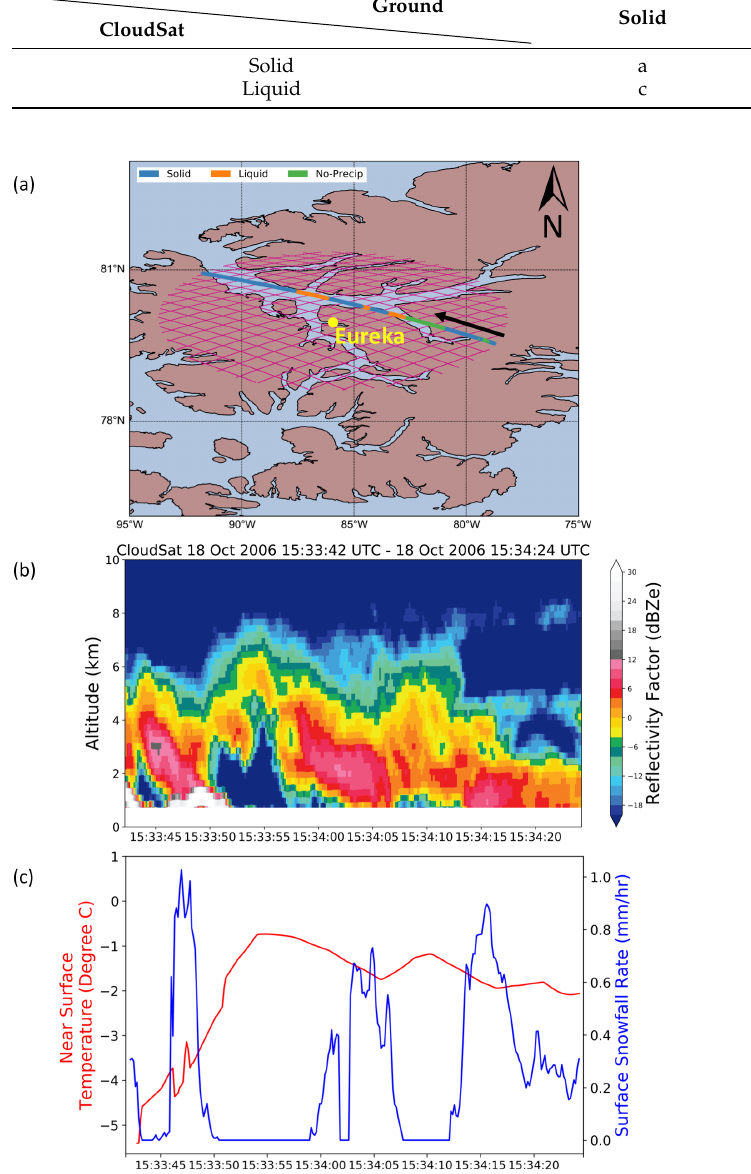
Figure 2. Figures demonstrating the details of the overpass validation methodology for a mixed precipitation event at Eureka, Nunavut recorded on 18 October 2006 at UTC 15:33. ( a ) A spatial radius of 100 km centered on Eureka weather station, and the magenta lines indicate the tracks of CloudSat overpasses included in this study. Each individual overpass comprises retrieval profiles recorded along the track every 0.16 s. The multicolored line shows one CloudSat overpass on 18 October 2006, with retrieval profiles color-coded by precipitation occurrence and type using the method described in Section 3.1. ( b ) The vertical profile of reflectivity measured by CloudSat along the overpass track. ( c ) The coincident time series of near-surface temperature from the CloudSat ECMWF-AUX product (red curve) and surface snowfall rate from CloudSat 2C-SNOW-PROFILE (blue curve) for the same overpass. Surface snowfall rates of zero indicate profiles coded either as no precipitation or as